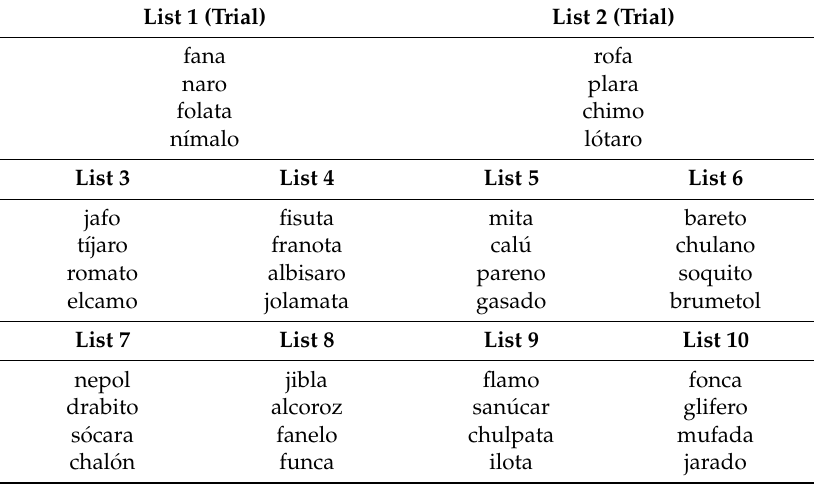
Table A3. Phonological Working Memory Task (span for